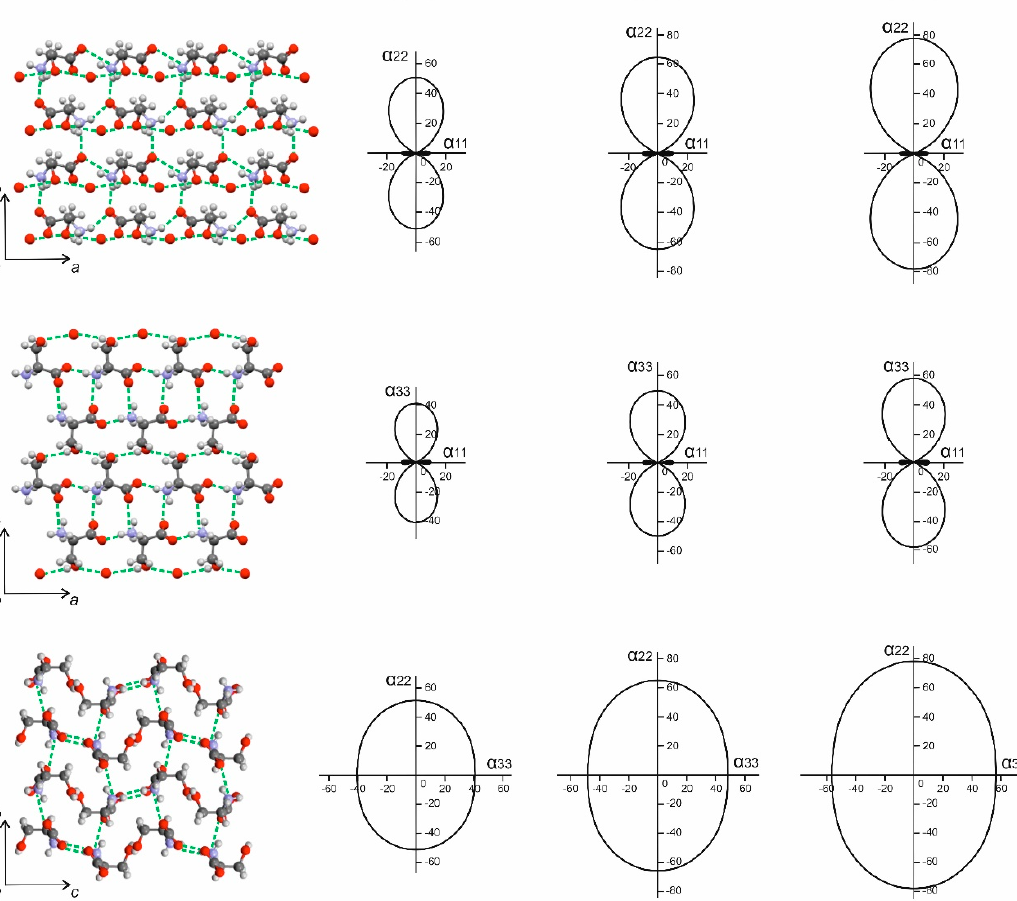
Figure 10. Projections of the figures of the thermal expansion coefficients (CTE) onto the ab , ac , and bc planes of the L-ser orthorhombic cell. The CTE figures are plotted for the temperatures of 23, 100, and 200 °C. Hydrogen bonds are shown as dashed lines. The projections of the orthorhombic cell are plotted using the structural data from CSD (identifier LSERIN41) [35].